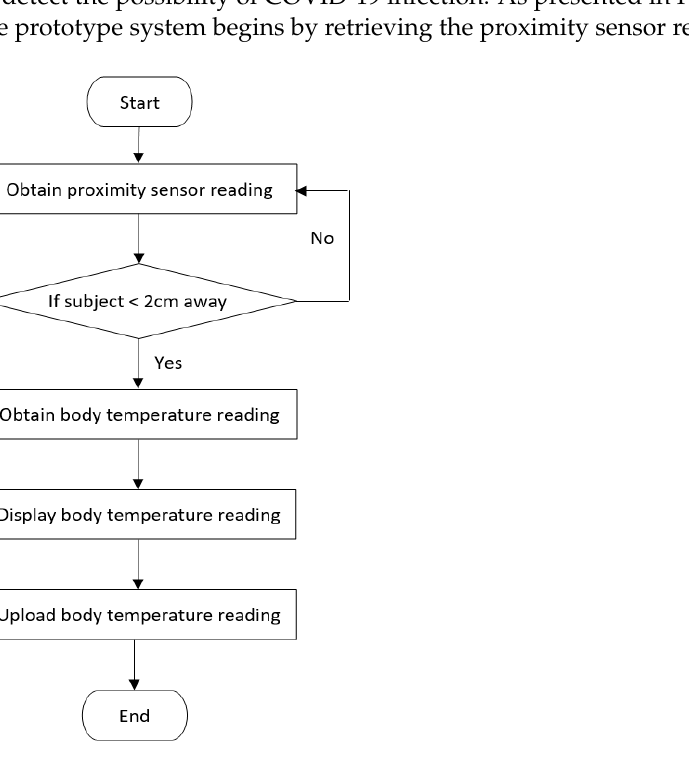
Figure 2. Workflow of IoT body temperature screening system.